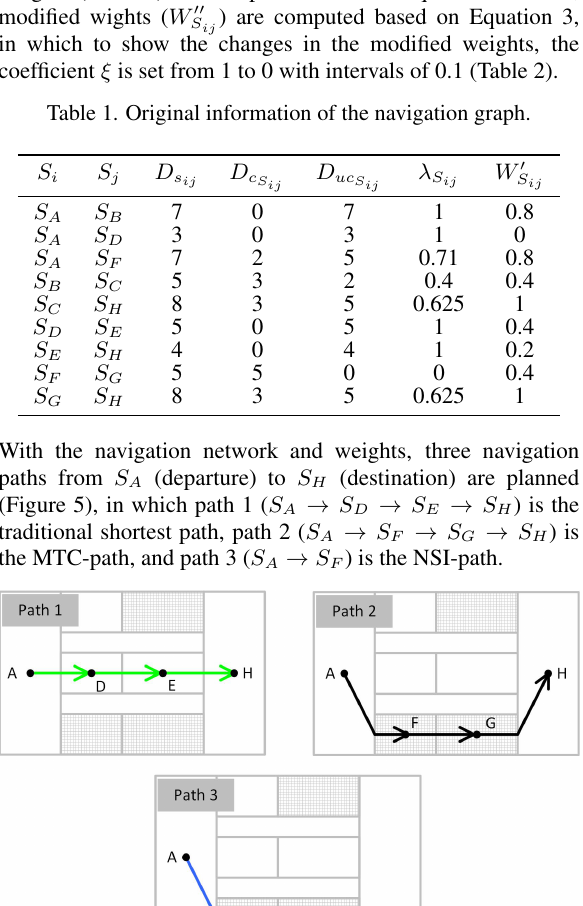
Figure 5. The three navigation paths from S A (departure) to S H (destination). S A → S D → S E → S H is path 1 (green), S A → S F → S G → S H is path 2 (black), and S A → S F is path 3